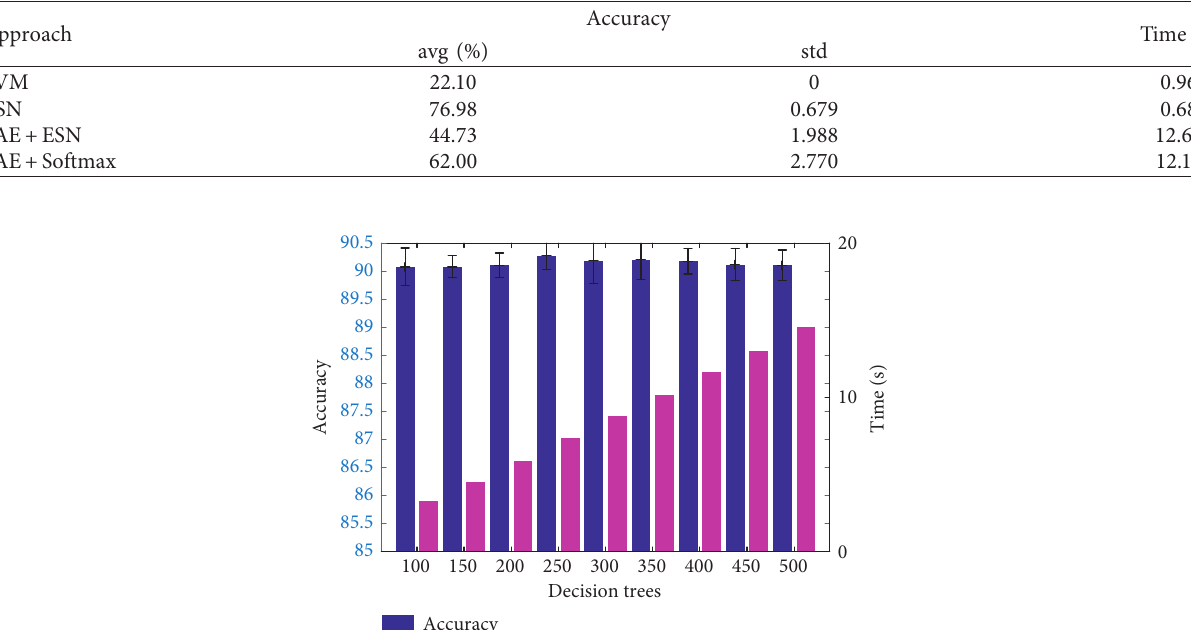
Figure 4: The experiment results for wind turbine gearbox based on SL classifier. (a) Recognition accuracy rate; (b) computing time. Table 2: Diagnosis results of different approaches.